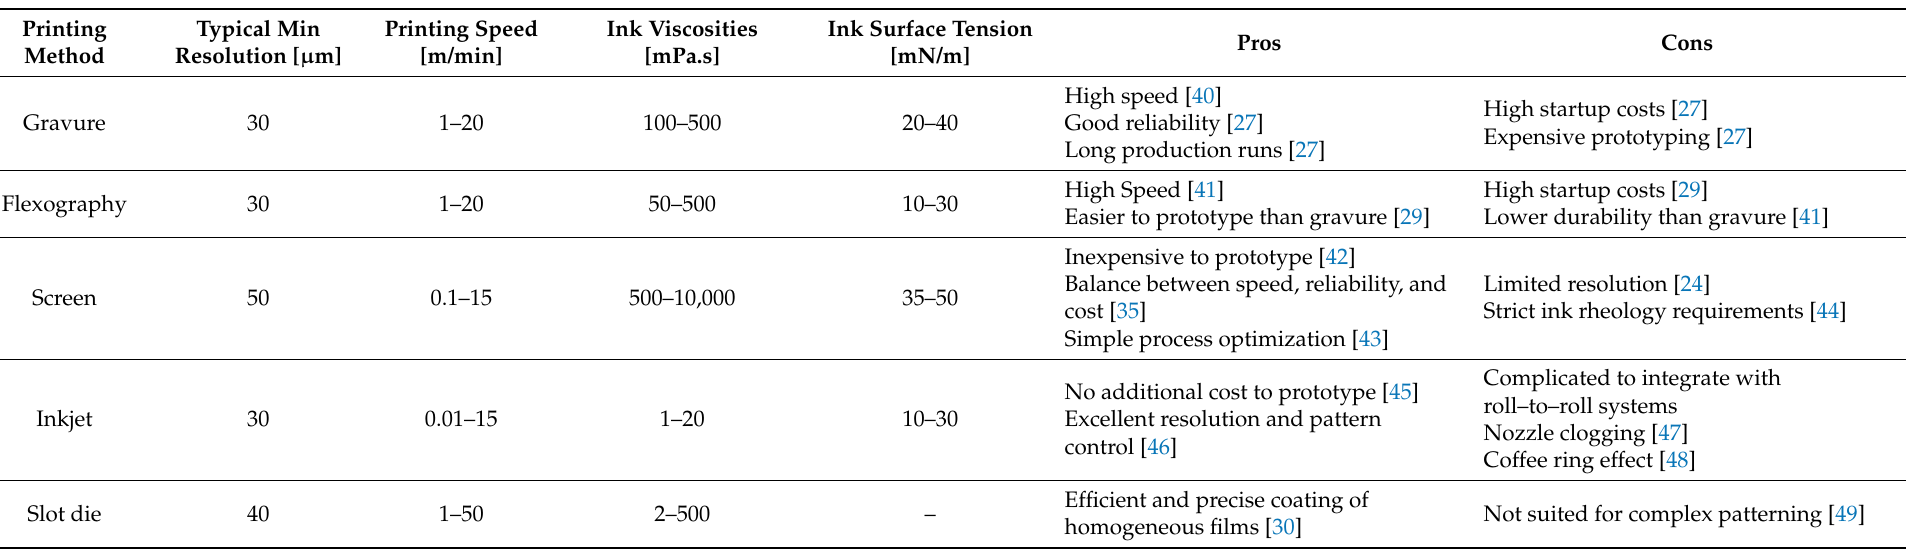
Table 1. Summary of nanomaterial fabrication methods with key advantages and